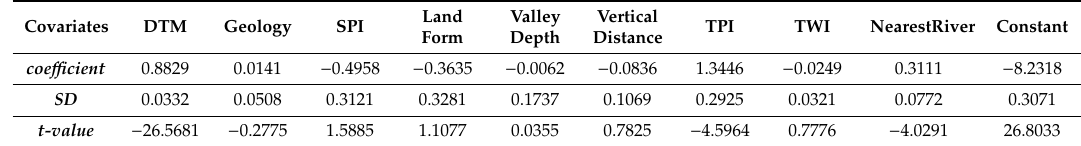
Table 6. The calculation results of coe ffi cients using 25%